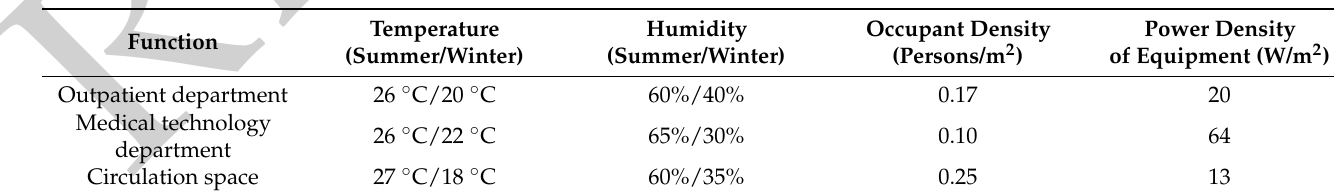
Table 4. Building design